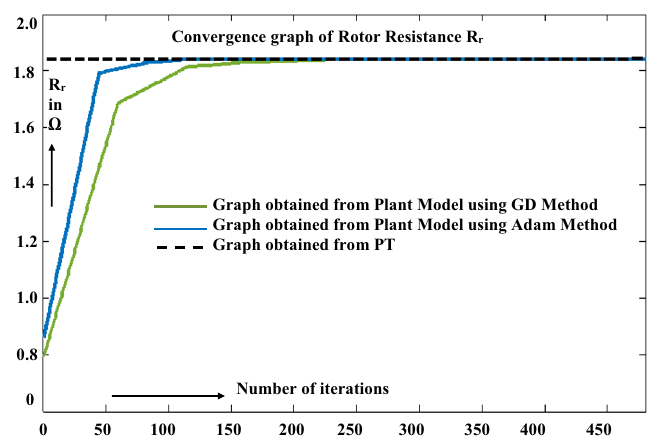
Fig. 11 Convergence of BPANN based estimation of rotor resistance R r